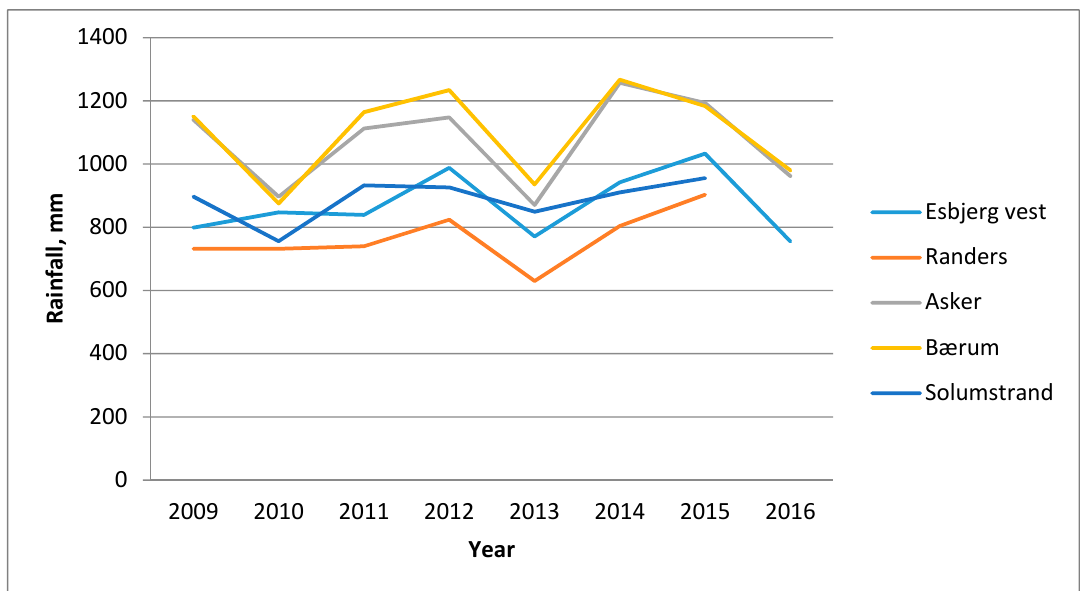
Figure 7. Rainfall in Asker, Bærum, Drammen, Randers, and Esbjerg vest.